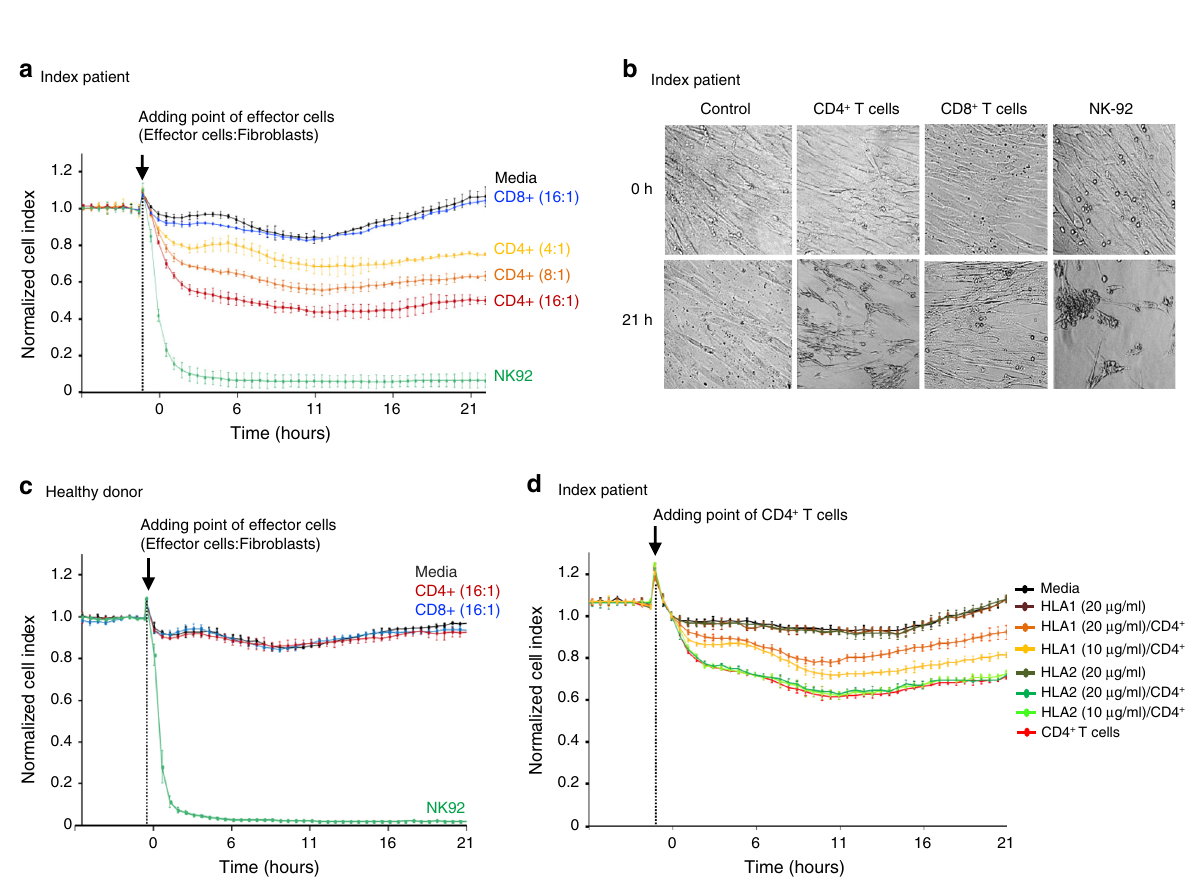
Fig. 5 Real-time monitoring of cellular cytotoxicity by electrical impedance measurement. Real-time cell analysing (RTCA) systems, xCELLigence TM , was applied to monitor real-time killing effect of primary fi broblasts obtained from the index patient and healthy donors. a Index patient ’ s primary fi broblasts were cultured as monolayers for 24 h to reach full con fl uence. Once con fl uent, the effector cells; NK-92 cell (positive control, 8:1), primary CD4 + T cells (4, 8, 16:1) and primary CD8 + T cells (16:1) with different ratios (effector cells: fi broblasts) were added to each well followed by co-culture (arrow indicates the point of adding the effector cells, 0 h). The control (black line, media) shows the impedance of the fi broblasts without any added effectors. The cell impedance was measured every 30 min for 21 h. The measured impedance was expressed as Cell Index with the normalization performed at time of addition of effector cells. b Visualization of monolayers of the primary fi broblast before and 21 h after addition of effector cells (8:1 for all effector cells). c CD4 + T cells and CD8 + T cells from healthy donors were added to healthy donors ’ own fi broblasts ( n = 3). The cell impedance was measured for 21 h. Data is representative of three independent individuals. d Index patient ’ s fi broblasts were seeded with HLA1 and HLA2 antibodies (10 and 20 μ g/mL). After CD4 + T cells (CD4 + T cells: fi broblasts = 8:1) were added the cell impedance was measured for 21 h. Dots represent mean values and error bars indicate range ( n = 2 for all conditions, technical duplicates). Source data are provided as a Source data fi